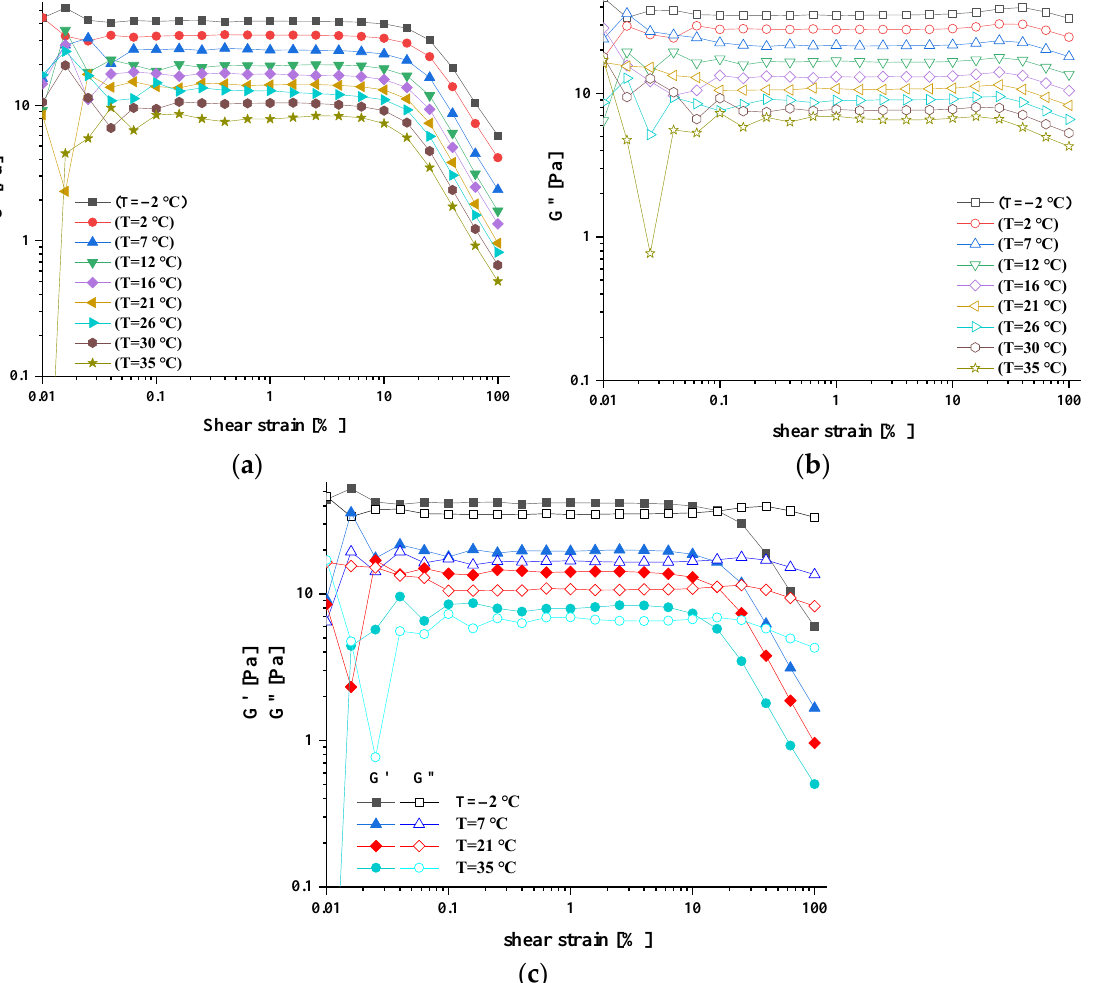
Figure 5. Amplitude scanning modulus curve of magnetic liquid at different temperatures: ( a ) storage modulus curve; ( b ) loss modulus curve; ( c ) control of the intersection of the two curves. When the shear strain is less than 10%, the viscoelastic modulus is independent of strain, and this region is called the LVE region. The effect of the increase of the applied shear strain on the G (cid:48) and G (cid:48)(cid:48) can be analyzed through its microscopic schematic diagram, as shown in Figure 6 [21]. The black is the magnetic particles, the white is the non-magnetic carrier fluid molecule, and the yellow is the energy storage modulus. In static equilibrium, FFs behave as a Newtonian fluid, freely composed of all magnetic particles and carrier fluid molecules, as shown in Figure 6a. Under the action of magnetic fields, FFs contain long chains, short chains of carriers, and free molecules, as shown in Figure 6b. When the strain is very small, G (cid:48) > G (cid:48)(cid:48) , and elastic behavior dominates sticky behavior. When the strain increases, G (cid:48) decreases [22] because the distance between the particles increases with the increase of the shear strain, weakening the chain structure of the FFs. In Figure